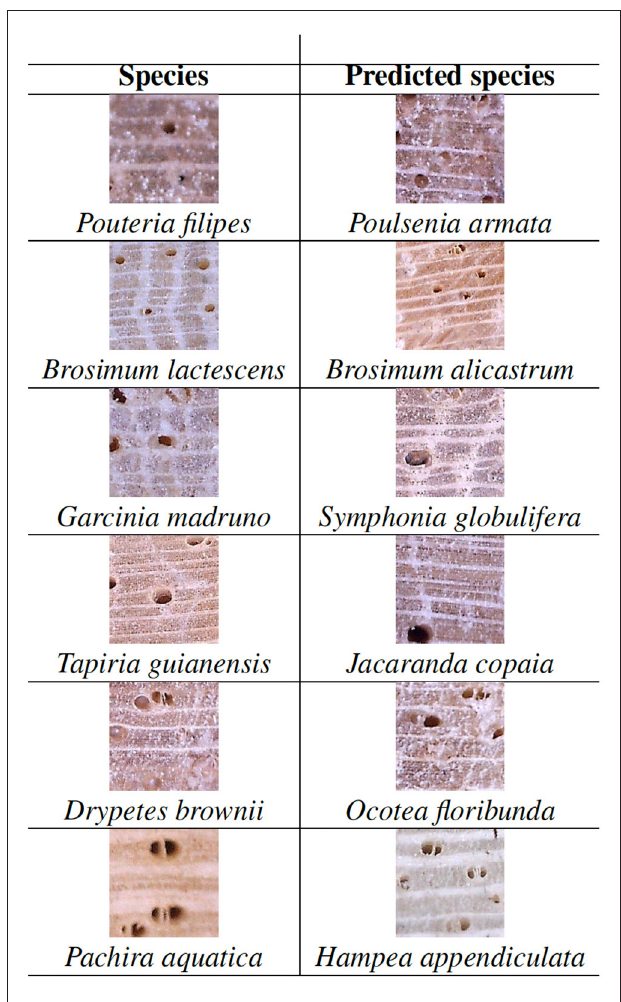
FIGURE 8 | Images of species never correctly identified and the top-1 predicted